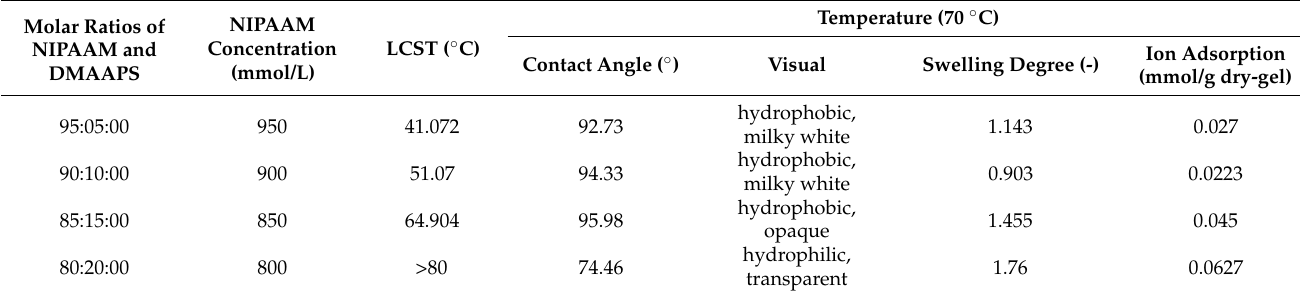
Table 4. Analysis results for co-polymers (phase transition temperature, contact angle, visual) and gels (swelling degree and ion adsorption) with various monomer ratios at 70 ◦